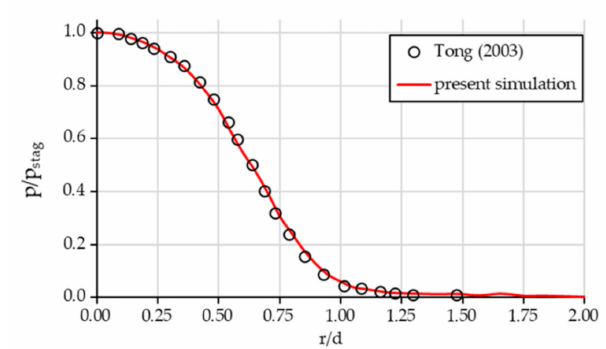
Figure 11. Dimensionless pressure distribution at the wall.